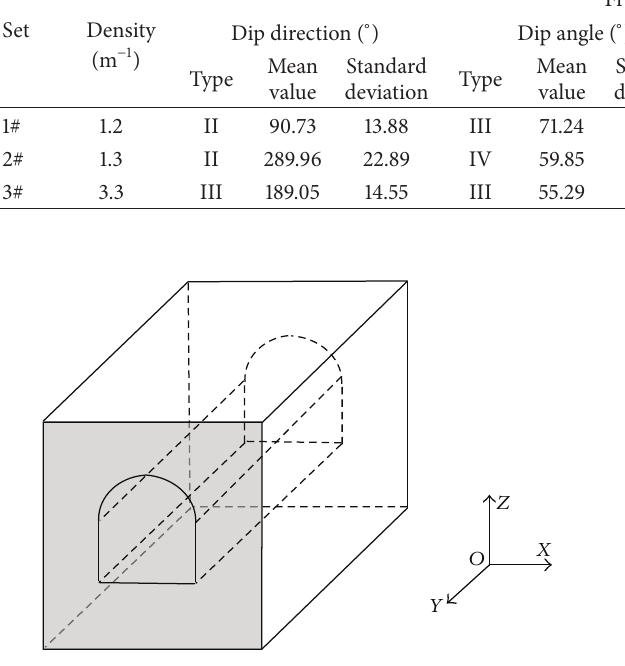
Figure 5: A diagrammatic sketch for underground